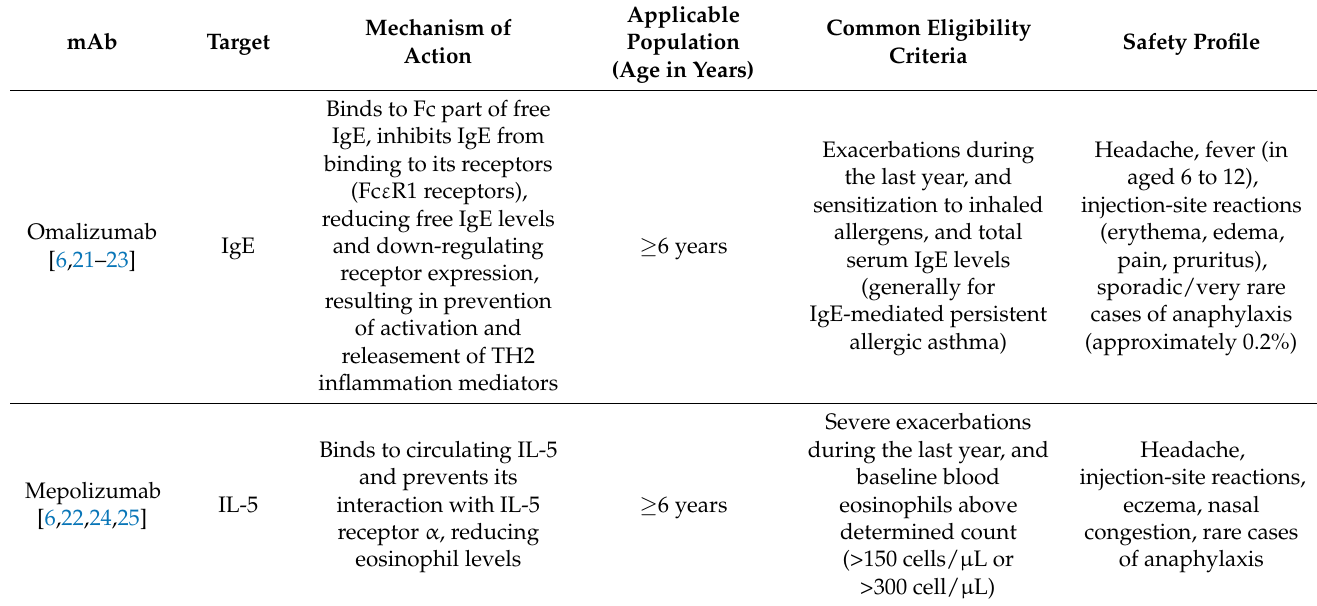
Table 1. Licensed monoclonal antibodies licensed for use in pediatric severe